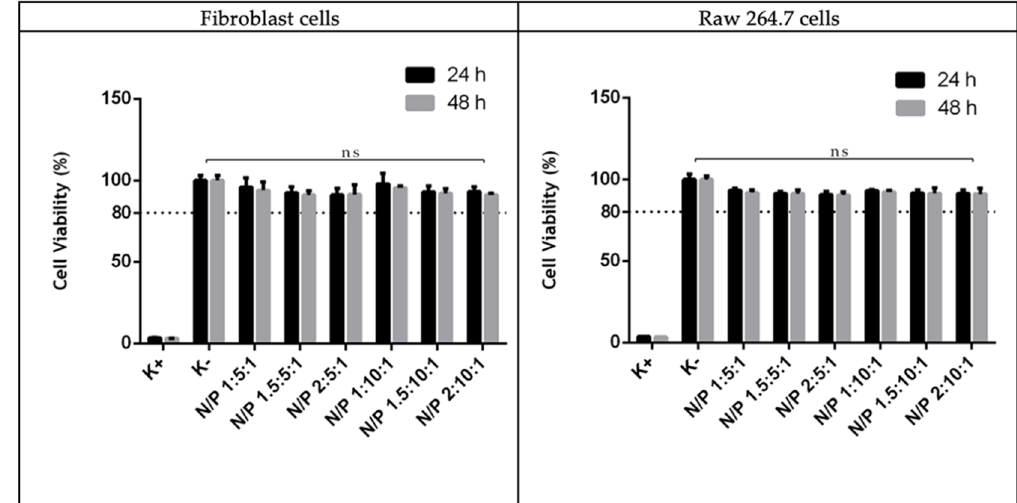
Figure 7. Cellular viability of human fibroblast and Raw 264.7 cells after 24 and 48 h incubation with R8-mannose/PEI/mcDNA particles at various N/P ratios. Percent viability is expressed relative to negative control cells. Non-transfected cells were used as negative control. Data obtained from three independent measurements (mean ± S.D., n = 3).